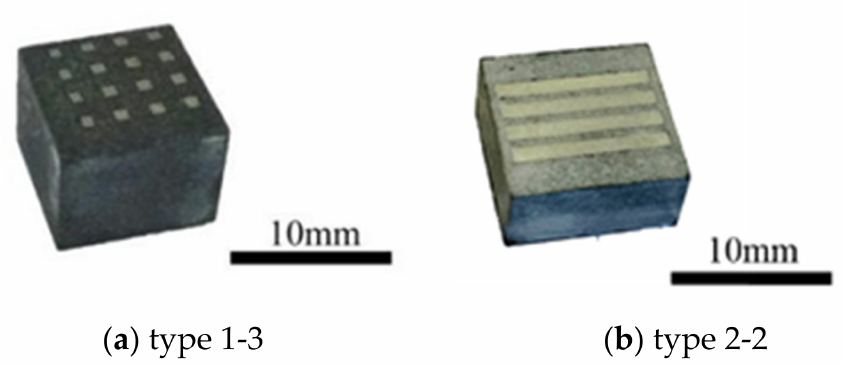
Figure 1. Samples of cement-based piezoelectric composites.